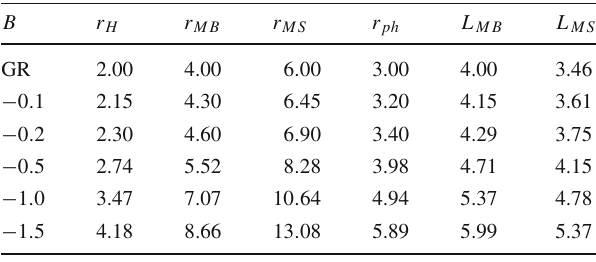
Fig. 2 The variation scalar curvature R as a function of r . All the quantities are expressed in dimensionless units, which is considered with c = G = M = 1